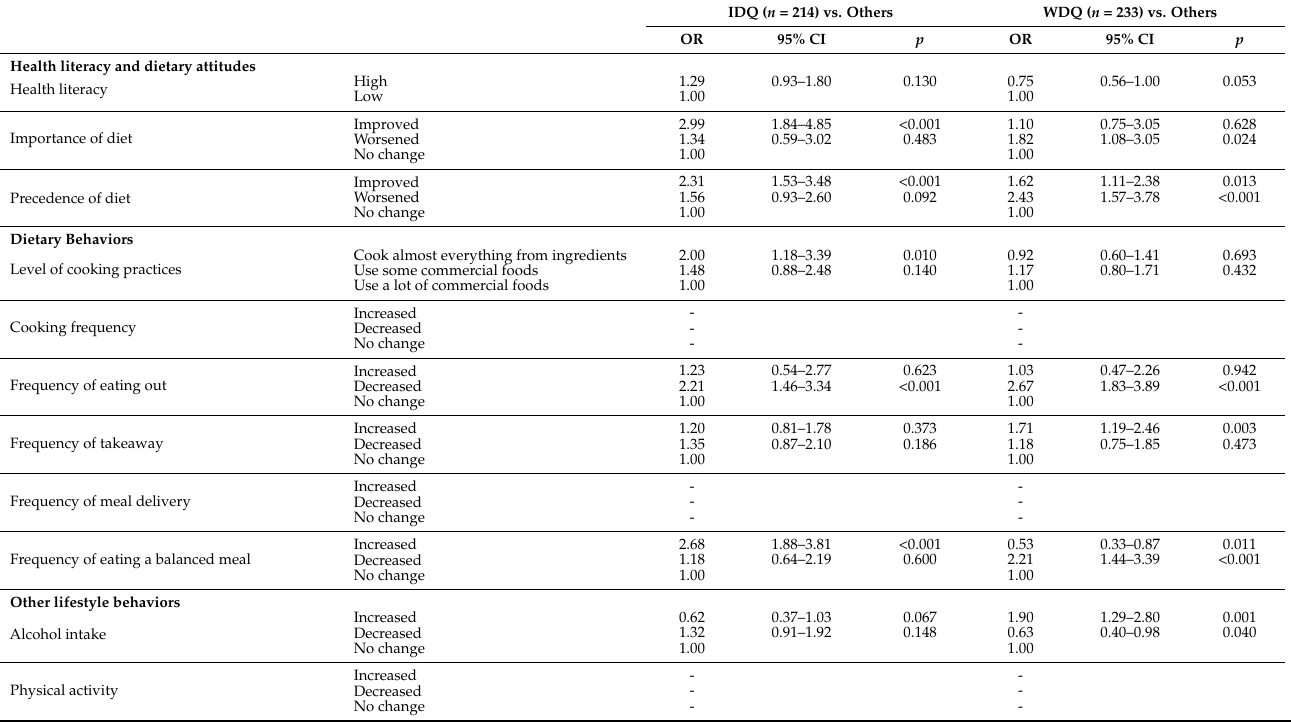
Table 4. Multinomial logistic regression analyses of the factors associated with changes in the diet